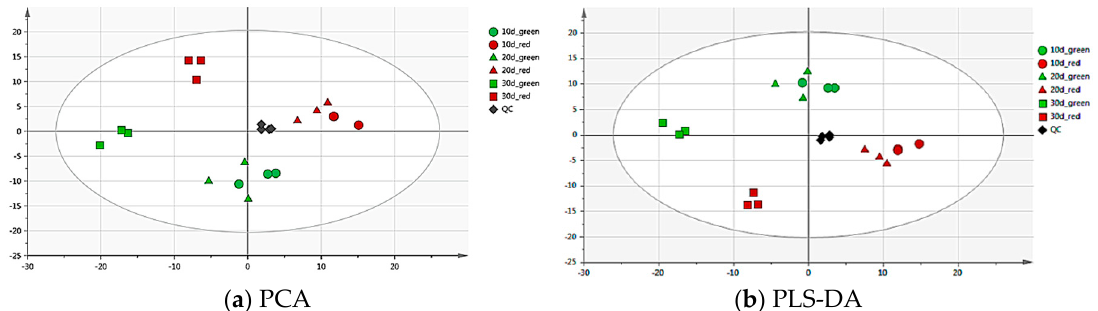
Figure 1. Principal component analysis (PCA) ( a ) and partial least squares-discriminant analysis (PLS-DA) ( b ) score plot. Score plots were derived using LC-ESI-MS/MS datasets from the red and green pod samples. The X axis represents PC1, and the Y axis represents PC2. Each sample has three biological duplicates, and is been represented on the plot by a unique symbol: the green circle, 10-day-old green pods; the red circle, 10-day-old red pods; the green triangle, 20-day-old green pods; the red triangle, 20-day-old red pods; the green square, 30-day-old green pods; the red square, 30-day-old red pods; the black diamond, QC.